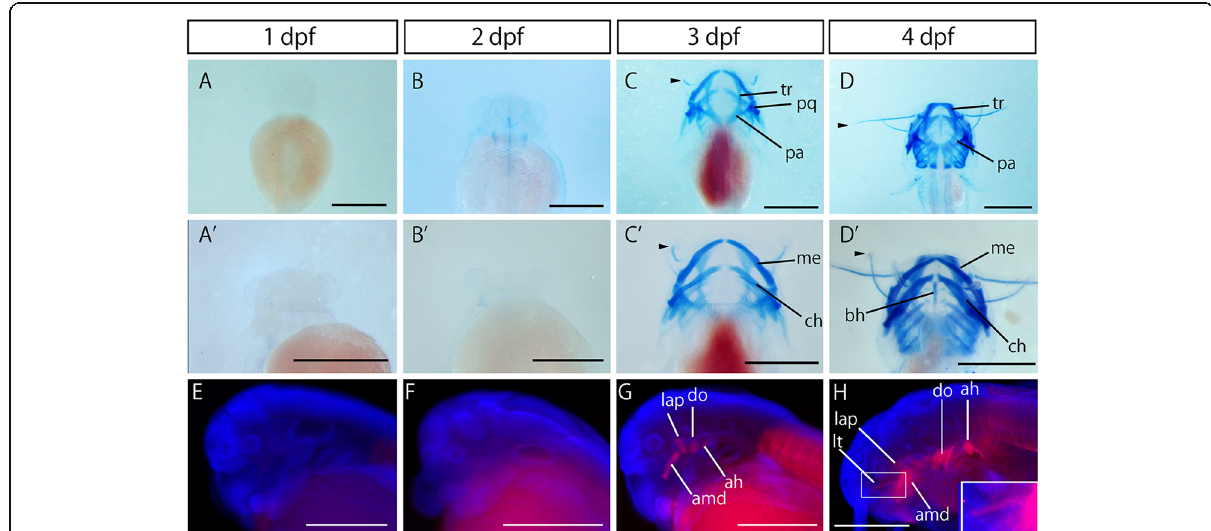
Fig. 4 Development of cartilages and muscles in Amur catfish. Cartilages stained by Alcian blue are shown in a – d. Myosin filaments stained by immunohistochemistry using anti-MF20 antibody are shown in e – h (in red). Blue staining in e – h shows nucleus labeled by DAPI. Dorsal views are shown in a – d. Ventral views are shown in a ′– d ′ . Lateral views are shown in e – h. Arrowheads in c, c ′ and d ′ indicate barbal cartilages. The inset in h indicates high magnification images of the box in h. ah, adductor hyomandibulae; amd, adductor mandibulae; bh, basihyal cartilage; ch, ceratohyal cartilage; do, dilator operculi; lap, levator arcus palatini; lt, levator tentacle; me, Meckel ’ s cartilage; pa, parachordal cartilage; pq, palatoquadrate cartilage; tr, trabecular cartilage. Anterior is the upper side in a – d and left in e-h. Scale bars are 1 mm in a – d, and 500 μ m in e –